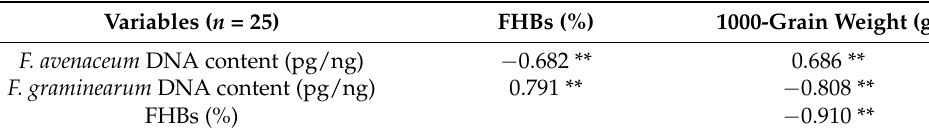
Table 3. Correlations between FHB severity (FHBs), 1000-grain weight and different ( F. avenaceum and F. graminearum ) fungal DNA content in wheat